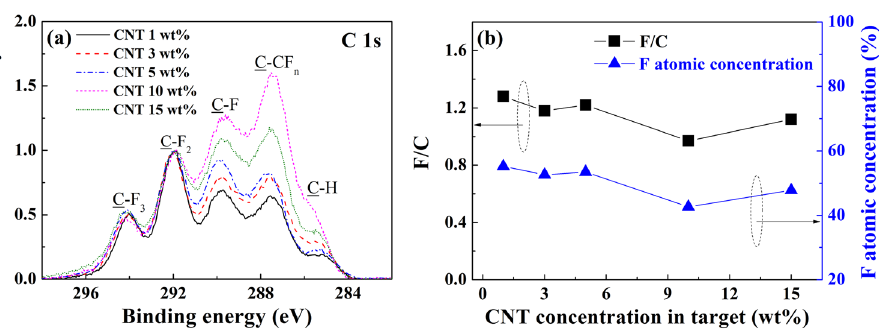
Figure 5. Normalized XPS spectra of ( a ) C-1s and ( b ) the calculated F/C ratio for the fluorocarbon thin films deposited using CNT/PTFE composite